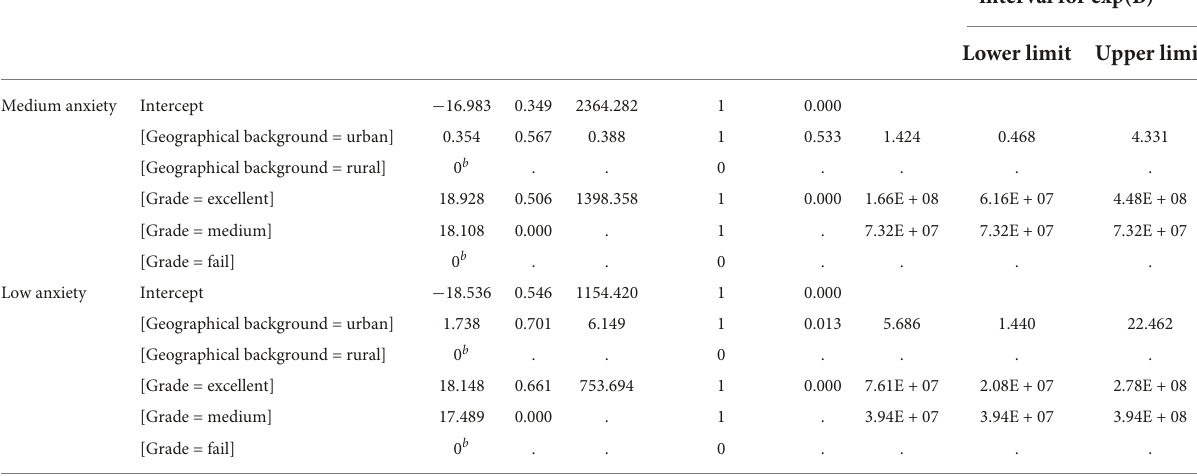
TABLE 10 Parameter estimation with high anxiety as a reference category. Grouping